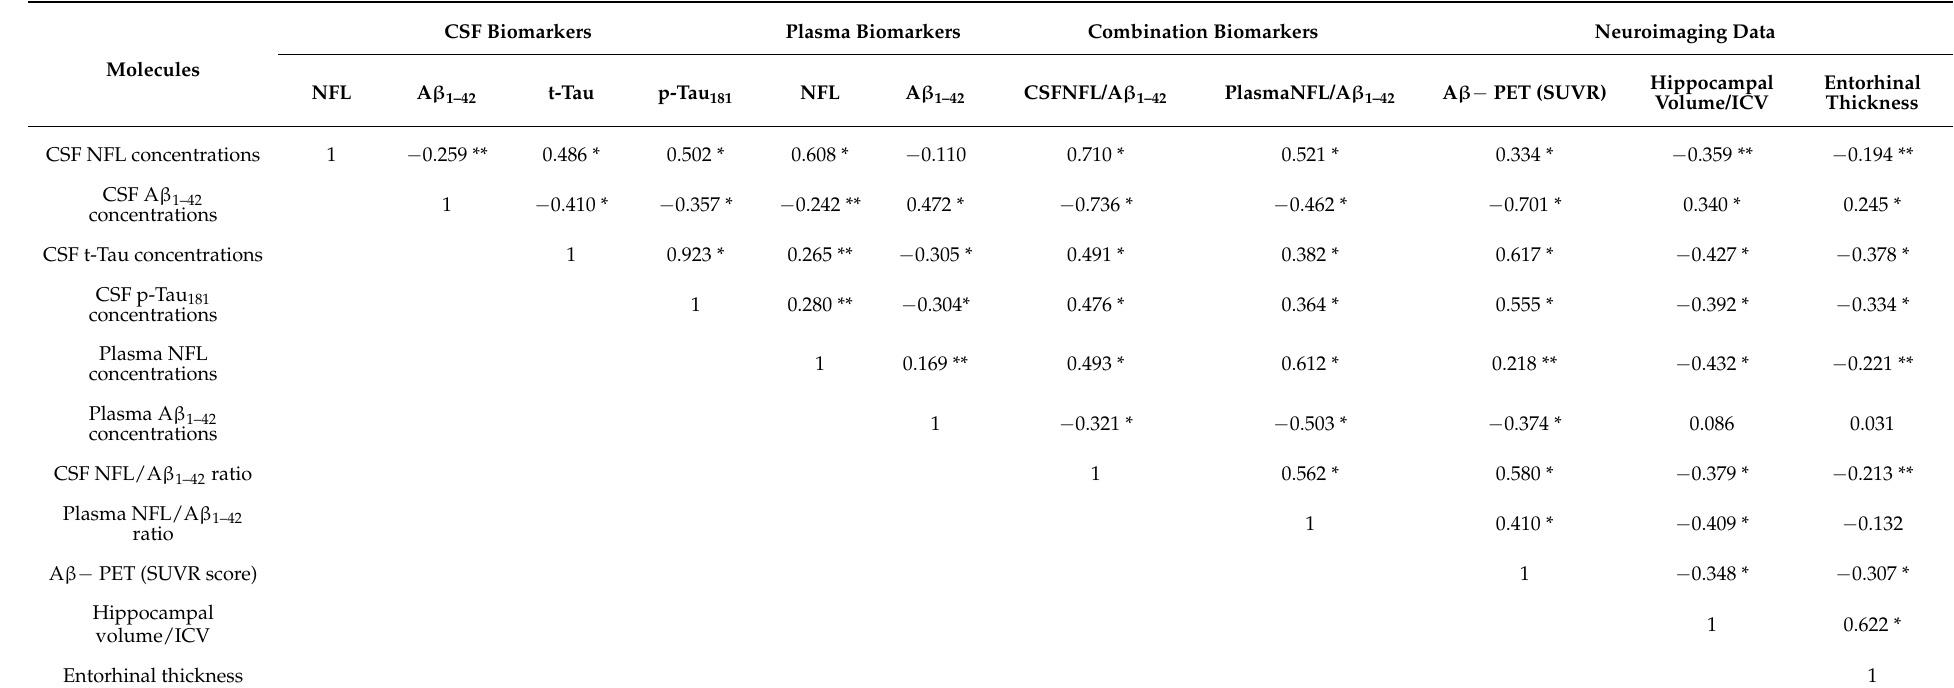
Table 2. Correlations between CSF biomarkers, plasma biomarkers, and neuroimaging